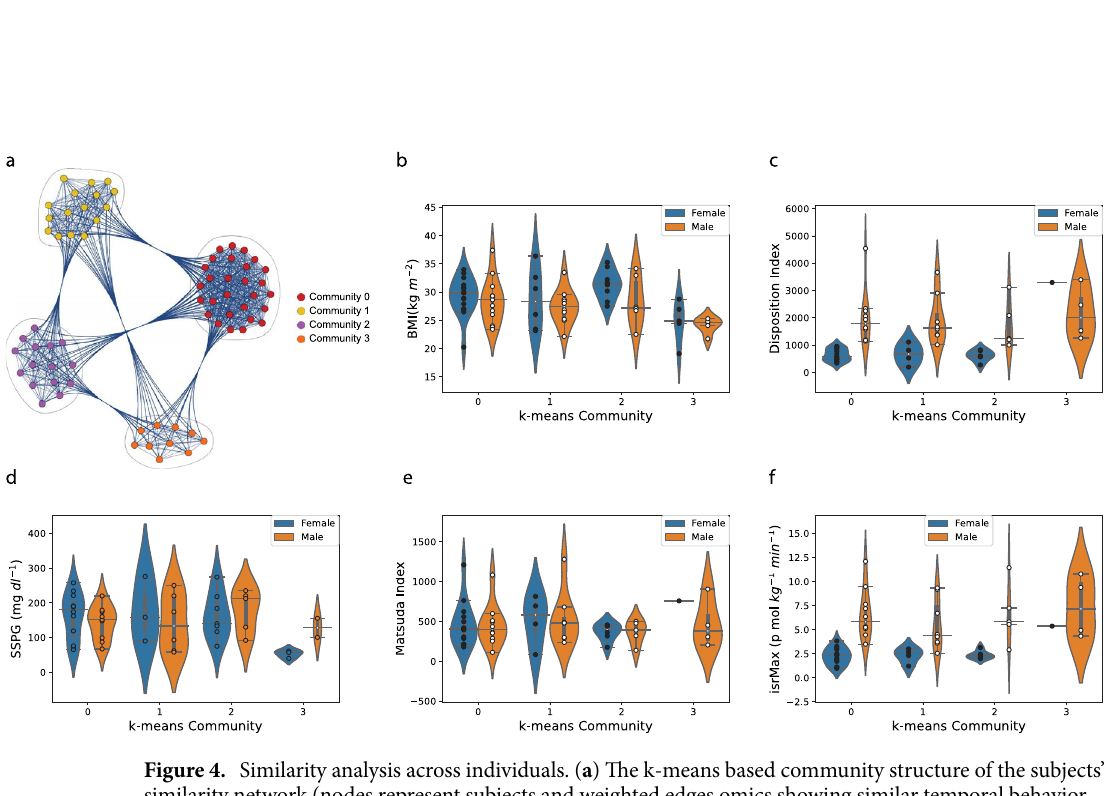
Figure 4. Similarity analysis across individuals. ( a ) The k-means based community structure of the subjects’ similarity network (nodes represent subjects and weighted edges omics showing similar temporal behavior across individuals). ( b )–( f ) Distributions of five types of measures in the 4 network communities by gender: ( b ) BMI; ( c ) DI, disposition index; ( d ) SSPG, steady-state plasma glucose; ( e ) Matsuda index and ( f ) isrMax, maximum insulin secretion